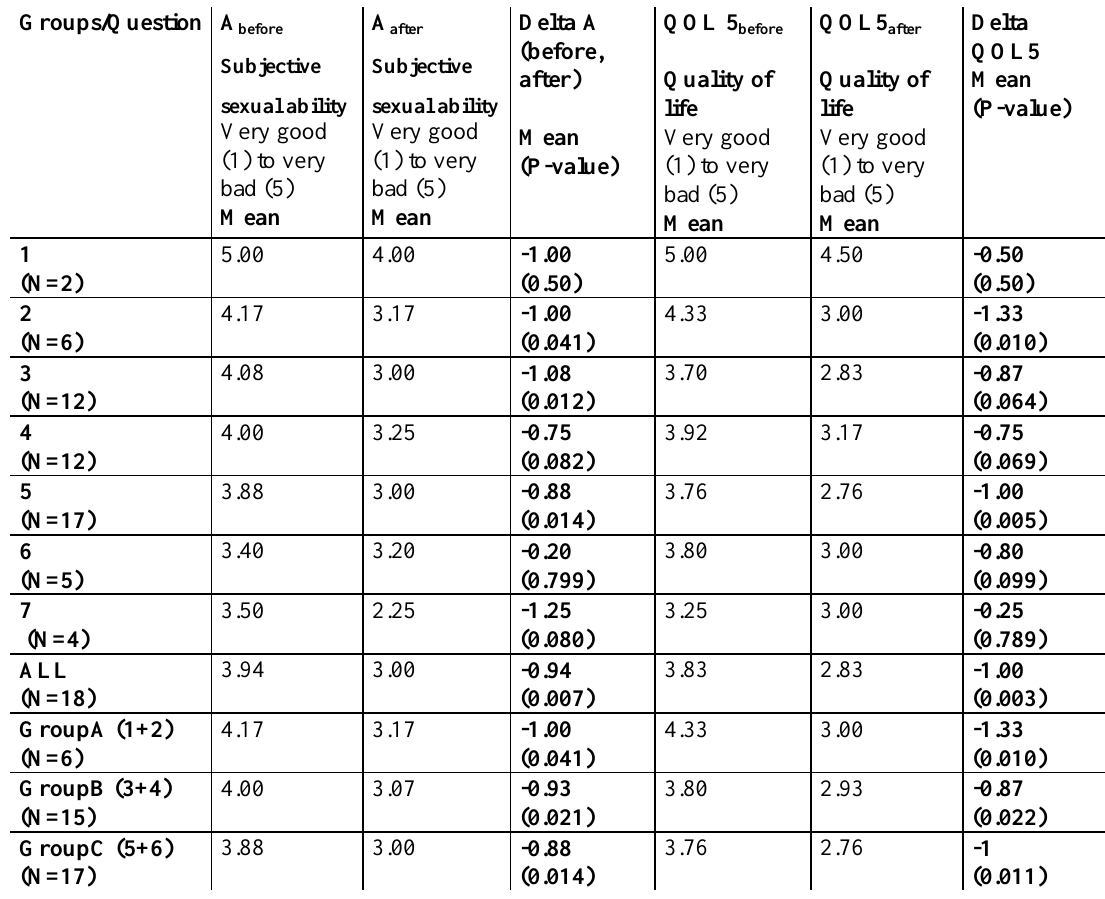
CLINICAL EFFECT OF VAGINAL